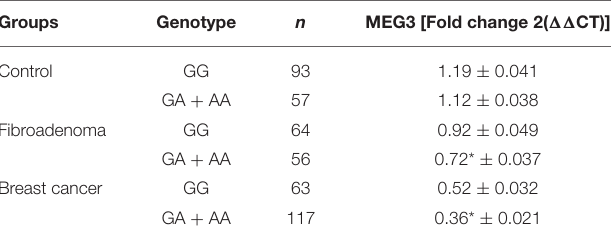
TABLE 3 | Differences in expression levels of MEG3 among different genotype carriers of MEG3 gene rs7158663 (GG and GA + AA) in study groups. Groups Genotype n MEG3 [Fold change 2( 11